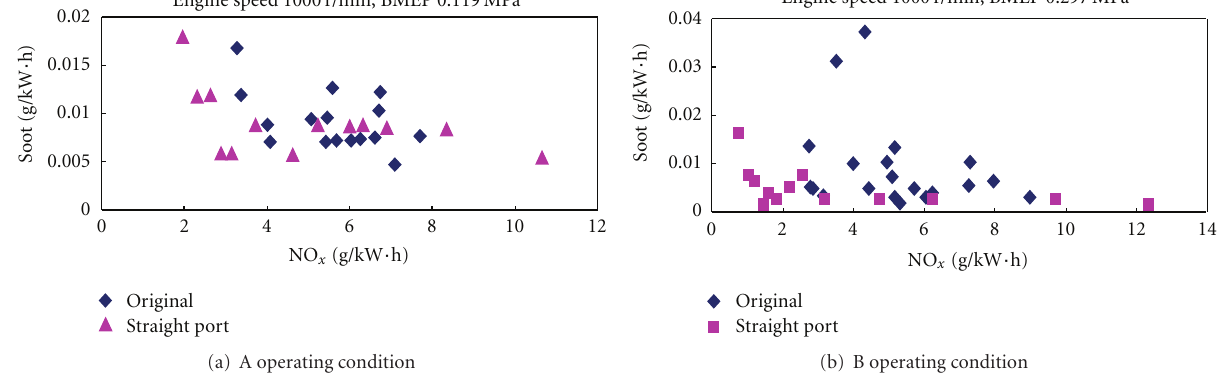
Figure 8: E ff ect of combustion chamber on NO x and soot emissions. Table 5: E ff ect of combustion chamber on combustion